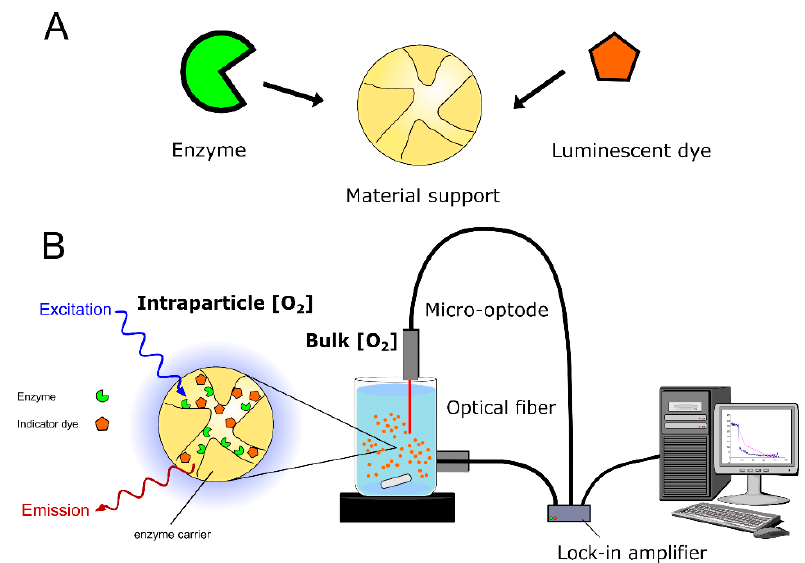
Figure 3. Opto-chemical sensing in enzyme immobilizates. ( A ) Preparation of analyte-sensitive carrier material and enzyme immobilization. ( B ) Application to space-averaged, time-resolved determination of internal concentrations. Figure 3B was adapted from reference [48] with permission from John Wiley and Sons .